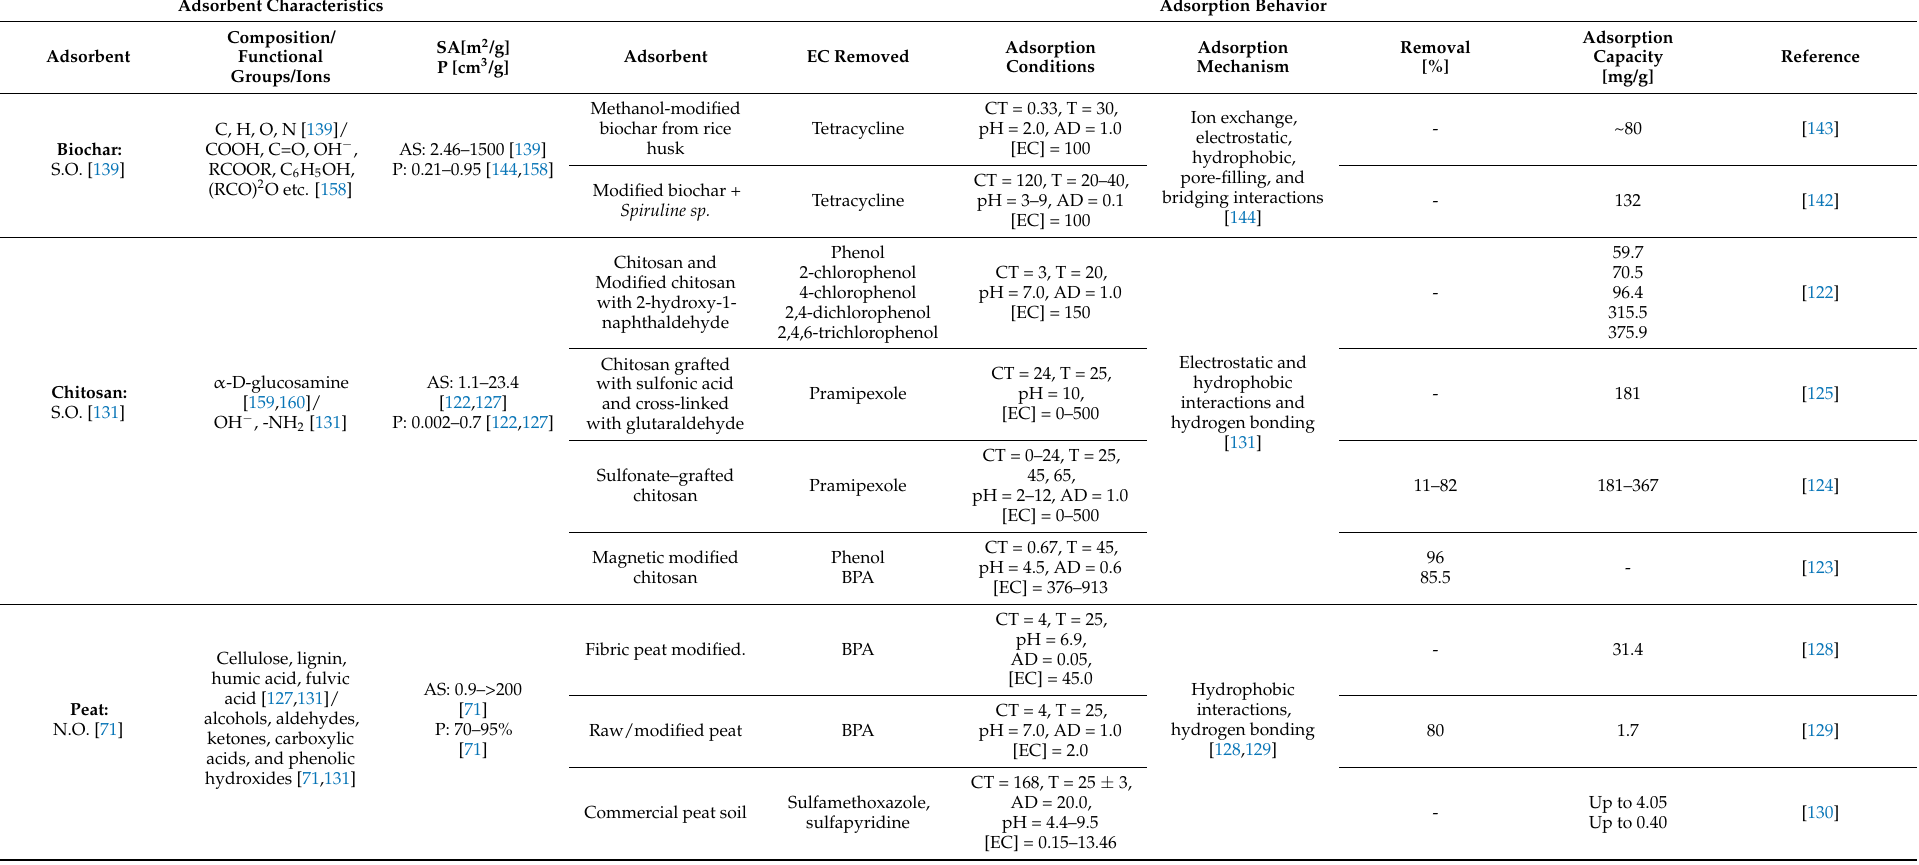
Table 4. Organic non-conventional materials used for EC removal from synthetic water in batch